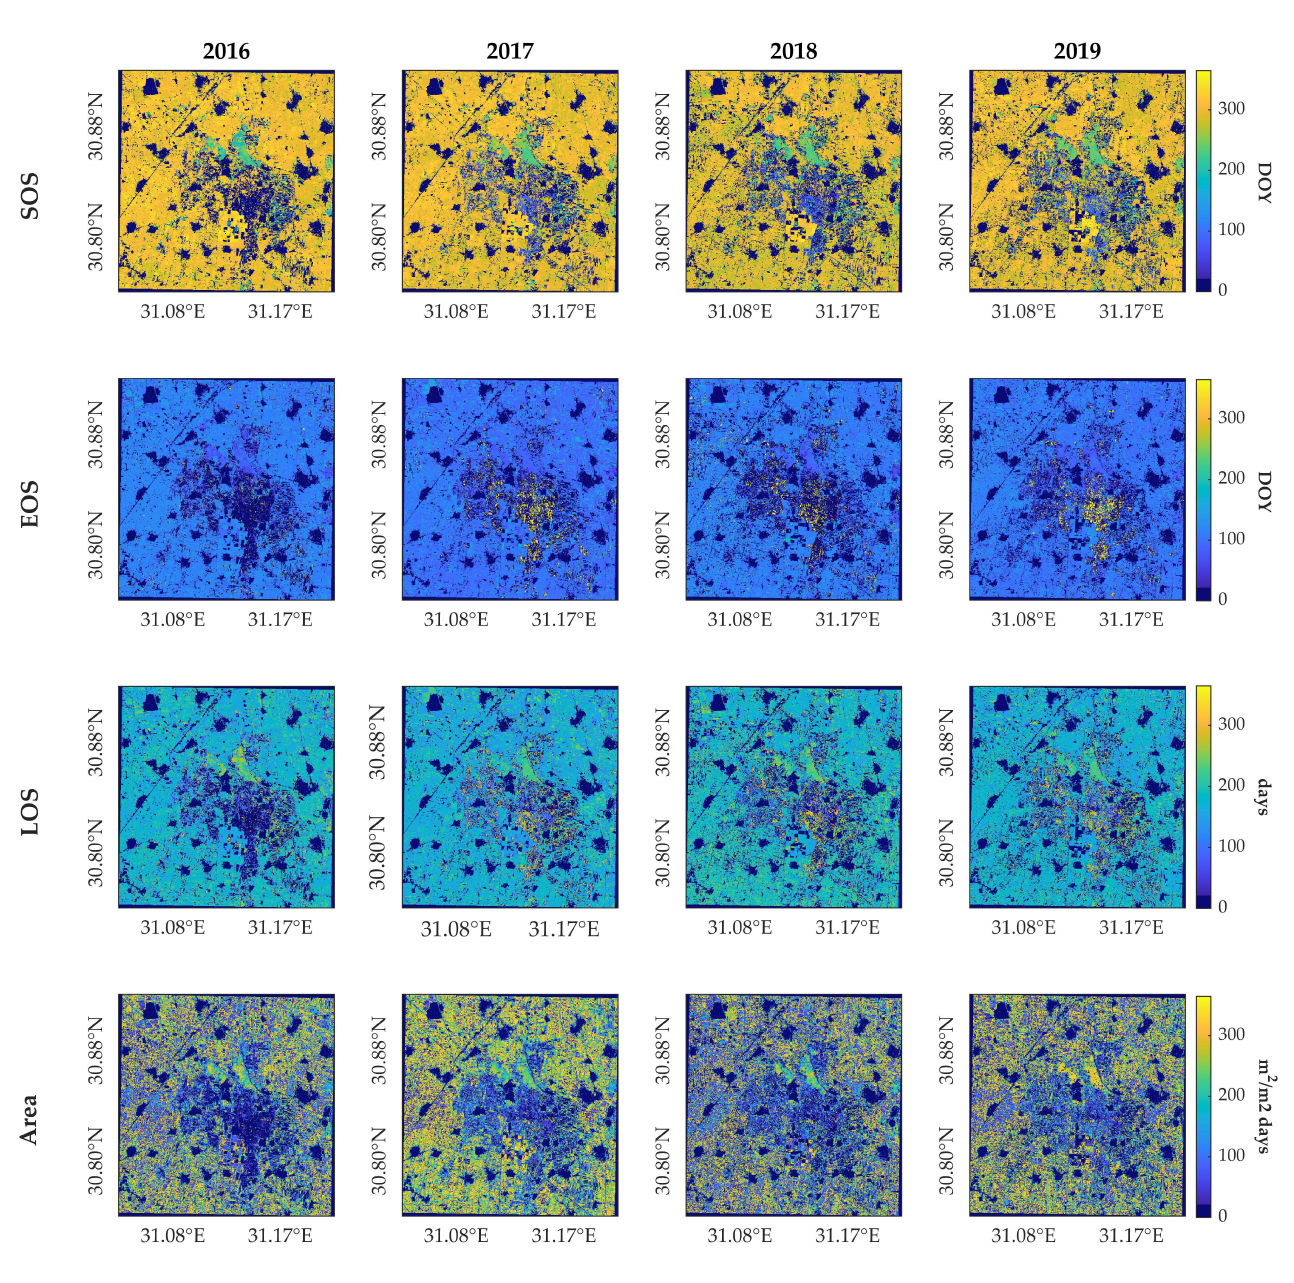
Figure 9. SOS, EOS, LOS and Area maps for the winter season from 2016 to 2019. EOS maps correspond to the following year to